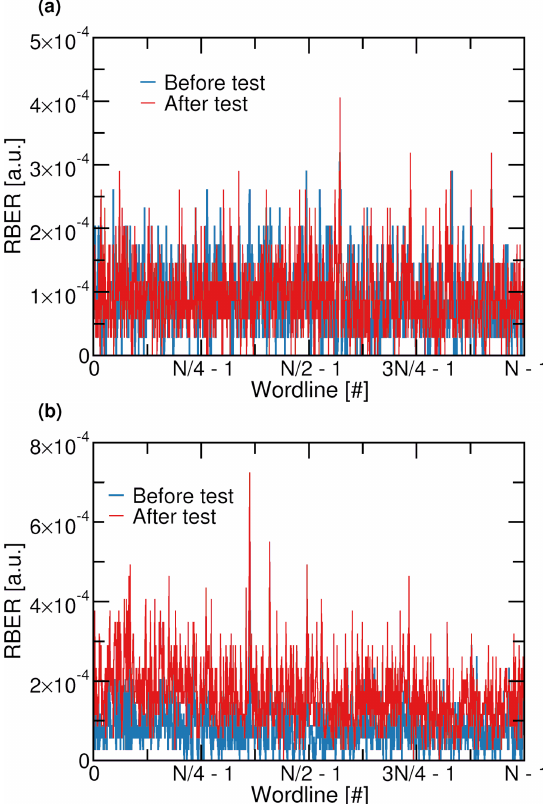
Figure 9. ( a ) The RBER measured in all the wordlines of a block where the program suspension took place. ( b ) The same measurements performed in a block where no program operation is issued.